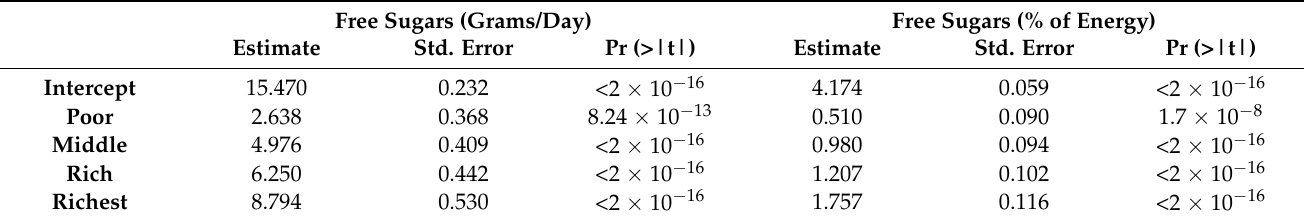
Table 11. Linear model for daily free sugar intake (g/d) regressed on the ordinal variable wealth. Estimates for the coefficients are in comparison with the “Poorest” level. Sample weights were used to fit the model. All p -values were <0.001.